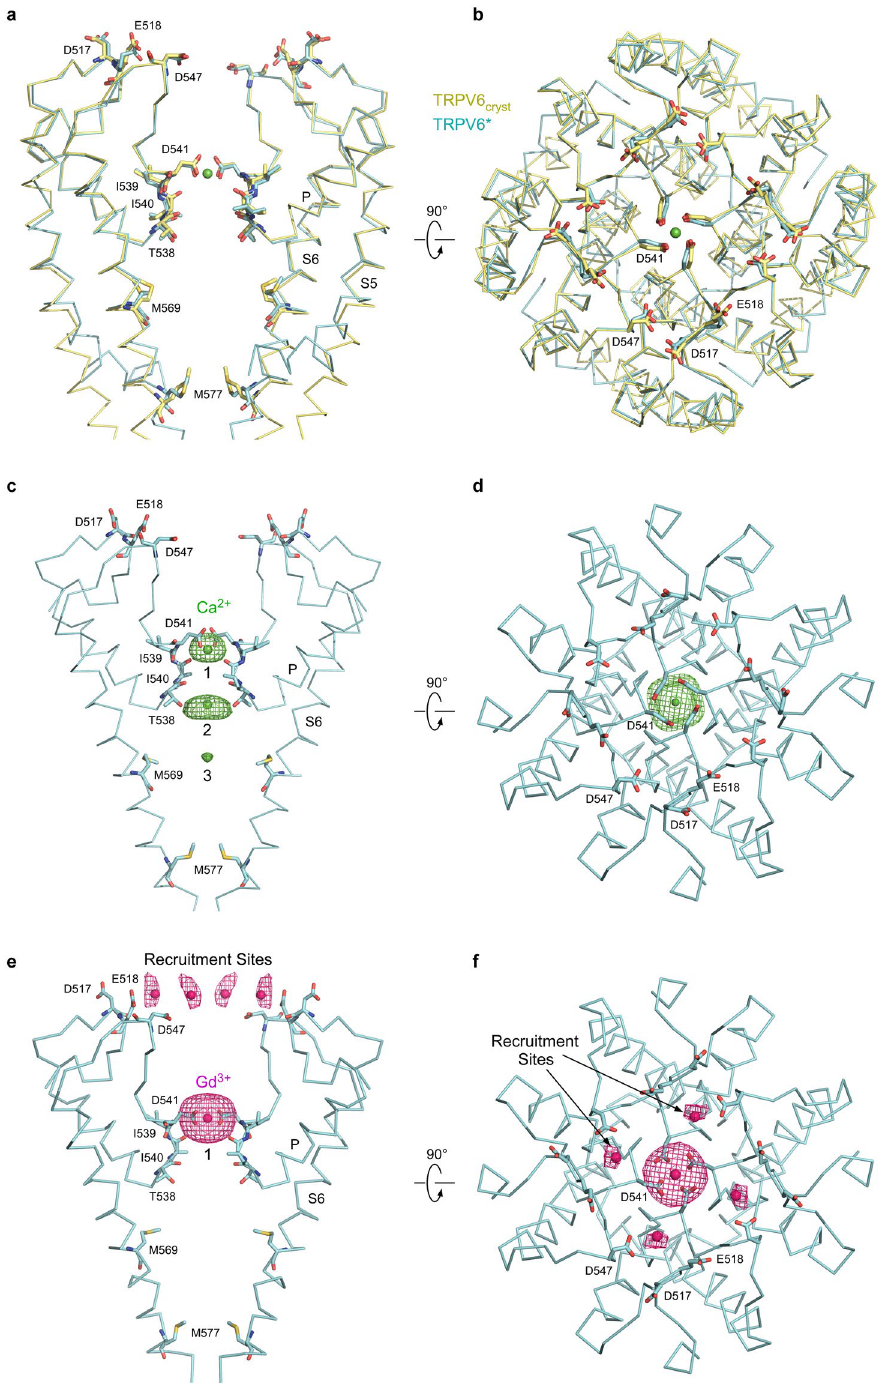
Figure 6. TRPV6 structures with swapped and non-swapped transmembrane domains have identical ion channel pores. ( a , b ) Superposition of the pore domains in TRPV6 * (cyan) and TRPV6 cryst (yellow) viewed parallel to the membrane ( a ) or extracellularly ( b ), with residues important for cation binding shown in stick representation. Calcium atom is shown as a green sphere. ( c – f) Side ( c,e ) and top ( d , f ) views of the TRPV6 * pore. Front and back subunits in c and e are removed for clarity. Green and pink mesh shows anomalous difference electron density for Ca 2 + ( c , d , 3 σ ) and Gd 3 + ( e , f , 3.5 σ ), respectively, and ions are shown as spheres of the corresponding color. Positions of cation binding sites are similar to TRPV6 cryst5